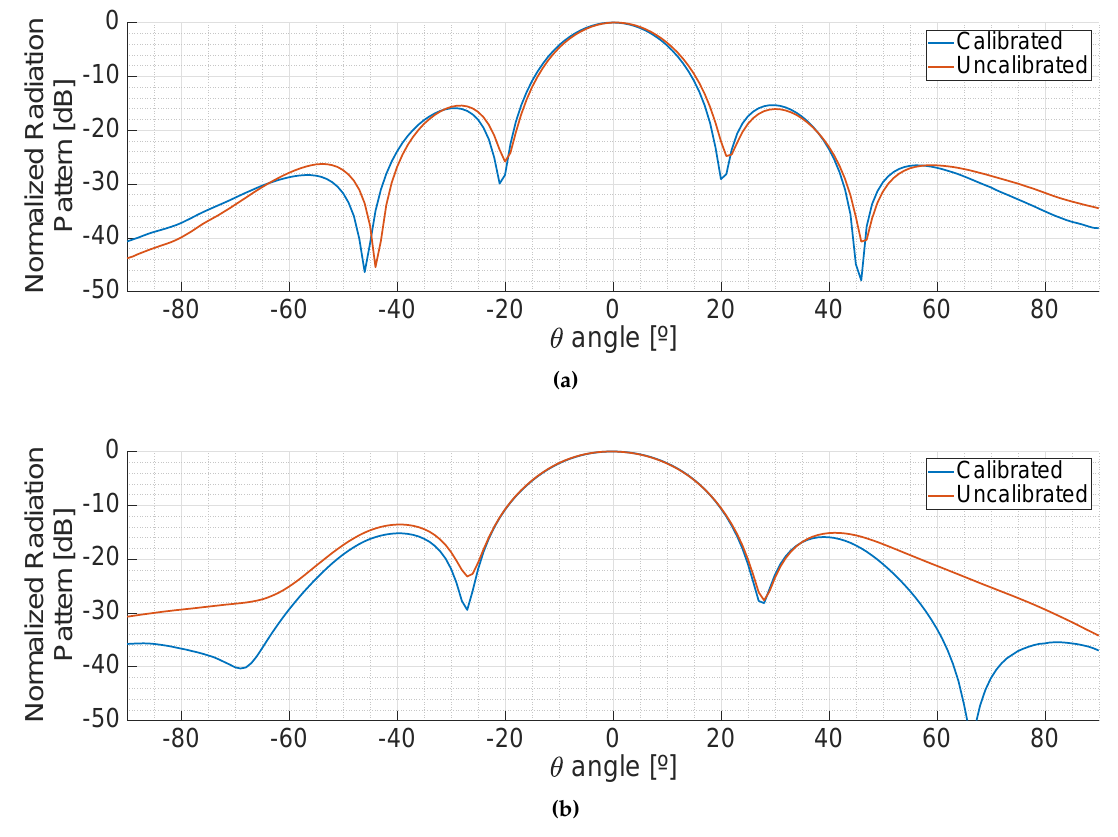
Figure 20. Effect of the calibration in the radiation patterns. Planar cuts in the ϕ = 30 ◦ plane at L1/E1 ( a ) and L5/E5 ( b